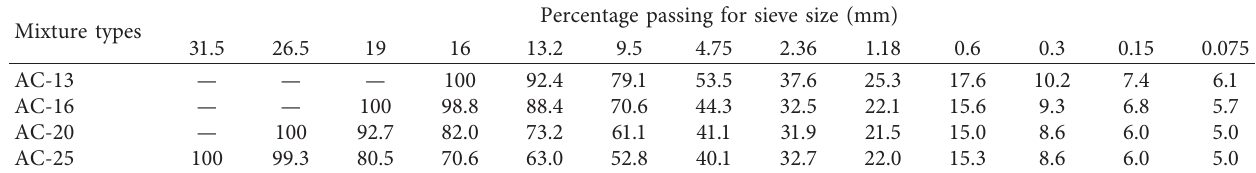
Table 2: Aggregate gradations of the different asphalt mixtures used in this study.